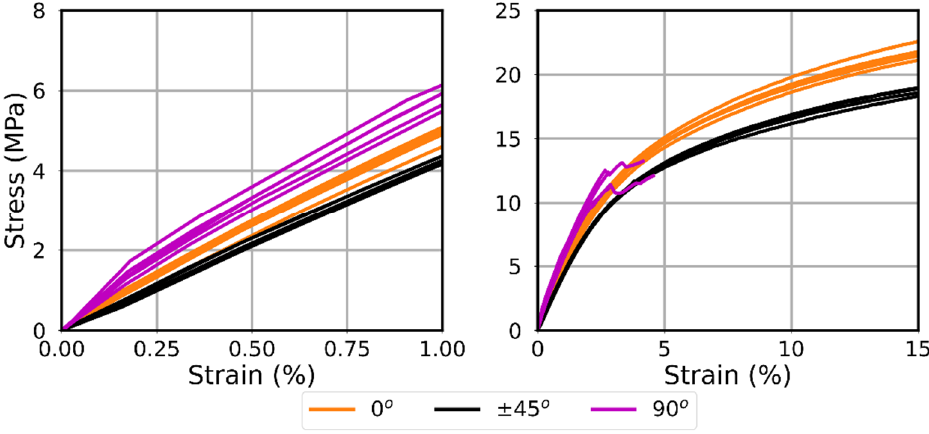
Figure 4. Stress–strain curves of the 0°, ±45°, and 90° specimens up to 1% and 15% strain. Table 1. Young’s modulus (GPa) and Poisson’s ratio (−) for the 0°, ±45°, and 90° specimens. 0° Specimen ± 45 ◦ Specimen 90 ◦